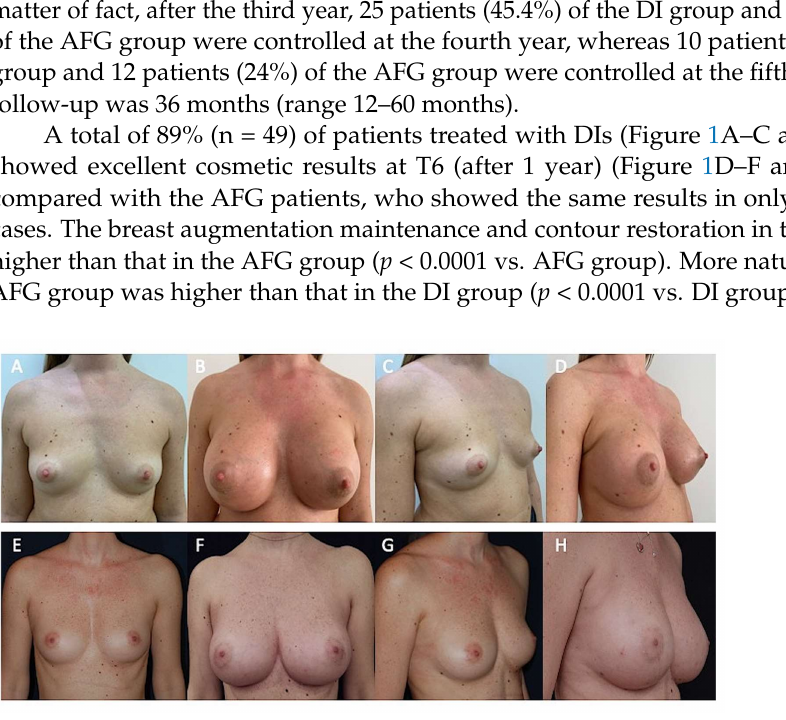
in comparison. ( A ) Pre-operative projection in frontal view. The patient shown in Figure 1 affected by a moderate grade of bilateral breast hypoplasia. ( B ) Post-operative projection after 1 year (T6) in frontal view. Patient treated with 320 cc definitive implant, positioned in the sub-glandular plane, bilaterally. ( C ) Pre-operative projection in 3 / 4 right view. ( D ) Post-operative projection after 1 year (T6) in 3 / 4 left view. ( E ) Pre-operative projection in frontal view. The patient shown in Figure 2 affected by a moderate grade of bilateral breast hypoplasia. ( F ) Post-operative projection in frontal view after 1 year (T6) and two procedures based on ASC-enriched AFG. An increase of 72.8 mm in the three-dimensional volume after 1 year (T6) was observed, evidencing a cosmetic result comparable with that obtained by definitive implants (shown in Figure 5B). ( G ) Pre-operative projection in 3 / 4 right view. ( H ) Post-operative projection in 3 / 4 right view after 1 year (T6) and two procedures based on ASC-enriched AFG evidencing the naturalness of the